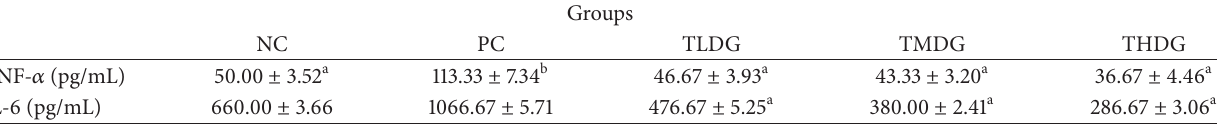
Table 6: Effect C . betacea extract on inflammatory biomarkers.